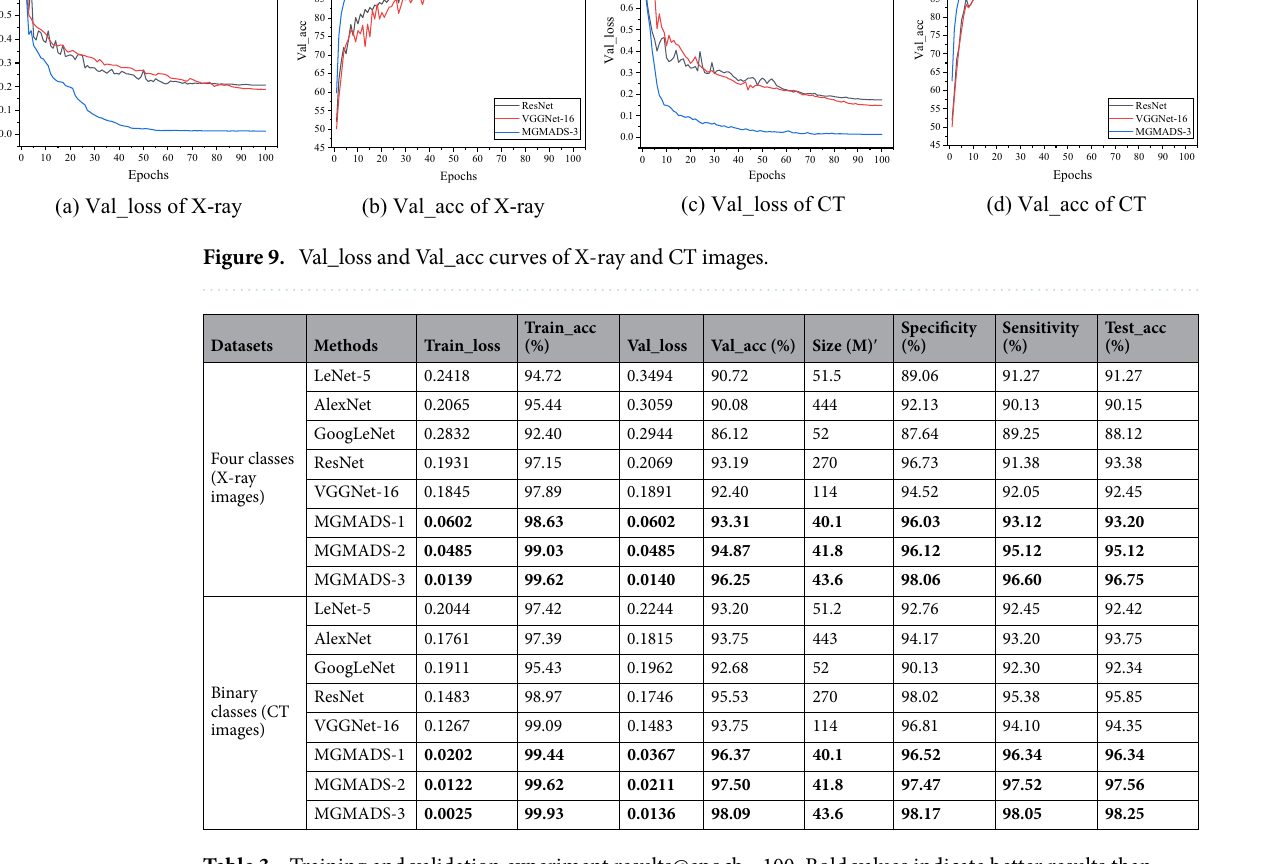
Table 3. Training and validation experiment results@epoch = 100. Bold values indicate better results than other